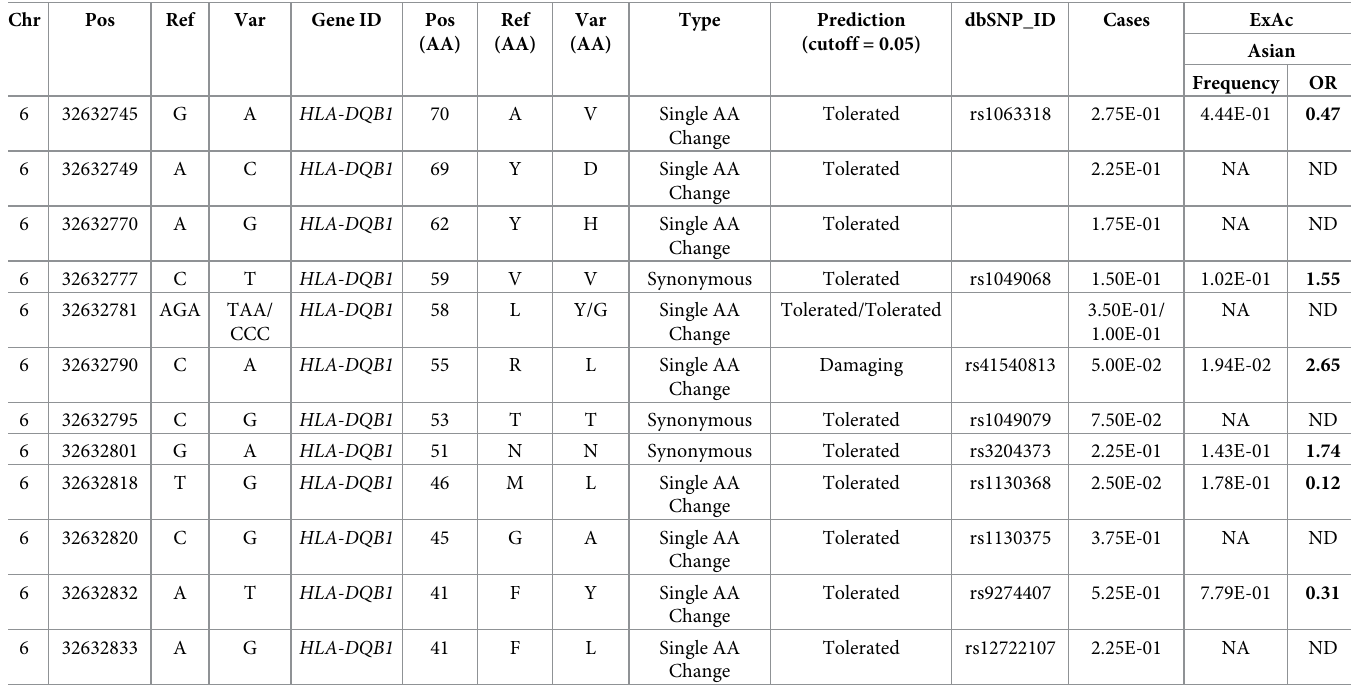
(S6 Table). The top 9 genes, including MICA and HLA-C , possessed 20 or more variants (one variant/case). We also summarized these 9 genes, including their ORs and compared them with the allelic frequencies registered in the databases (S7 Table). In these variants, one variant each of ITPKB , MICA , and PSMA7 exhibited ORs > 1.5 (compared with the allelic frequencies registered in the databases), while one variant of P2RX7 had an OR < 0.67. Damaged exon variants with allelic frequencies less than 0.01 (Selection of Candidate 3). We narrowed down candidate alleles based on the damage described above, exhibiting variant allelic frequencies < 0.01 in the databases, but � 0.05 in autoimmune FXIII deficiency cases. As a result, 64 variants met the criteria, while 440 variants were not registered in the alle- lic frequency database (S8 Table). A total of 504 of these were selected as candidate alleles. With respect to the number of variants per chromosome, chromosome 3 had the largest num- ber of variants, accounting for approximately 16% of the total variants (S2 A Fig). Homozygous variants accounted for about 43%, while heterozygous variants accounted for the remaining 57% of the total variants (S2 B Fig). The deletion number in each patient was observed from 30 to 68 with a median of 43, which occupied approximately 50% of the total (S2 C Fig). The SNP number was 13–37 with a median of 27, the MNP number was 4–10 with a median of 6, and the insertion number was 4–15, with a median of 11. When classified by codon mutations due to exon variants, the frameshift mutations were found to be the highest, about 55% (S2 D Fig). We further selected five candidate alleles based on 10 or more (half or more) cases with the terms, “heterozygous” or